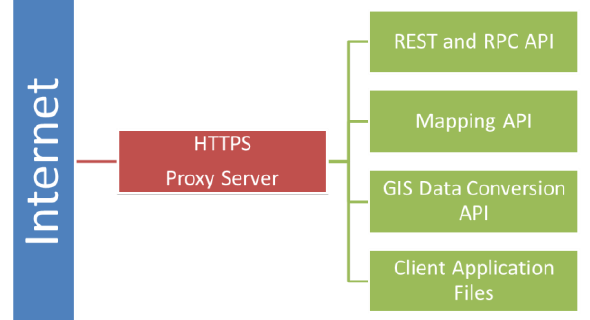
Figure 1. General architecture of the QNHER